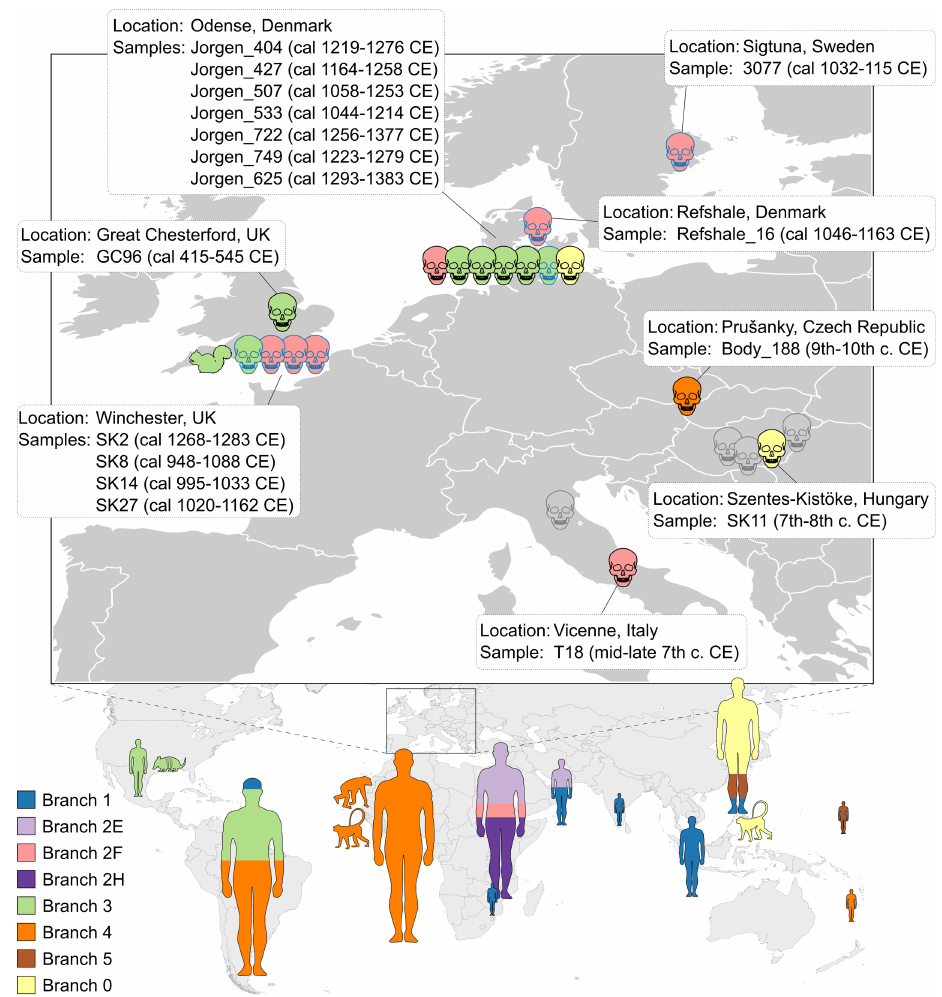
Fig 1. Worldwide distribution of the ancient and modern M . leprae strains analyzed in this study. Skulls represent strains from osteological specimens dated to the Medieval Period. Human silhouettes represent modern strains, sized to scale according to the number of samples, ranging from 1 (e.g. India) to 36 (South America) Animal silhouettes represent strains from the red squirrel, the nine-banded armadillo, and naturally infected nonhuman primates (a chimpanzee from Sierra Leone, a sooty mangabey from West Africa, and a cynomolgus macaque from The Philippines). Skulls outlined in black are the new M . leprae genomes reconstructed in this study, while skulls outlined in blue represent previously sequenced ancient genomes. Grey skulls are leprosy samples from this study that did not yield sufficient sequence for whole-genome analysis. The main M . leprae lineages, represented by branches (see Fig 2) are